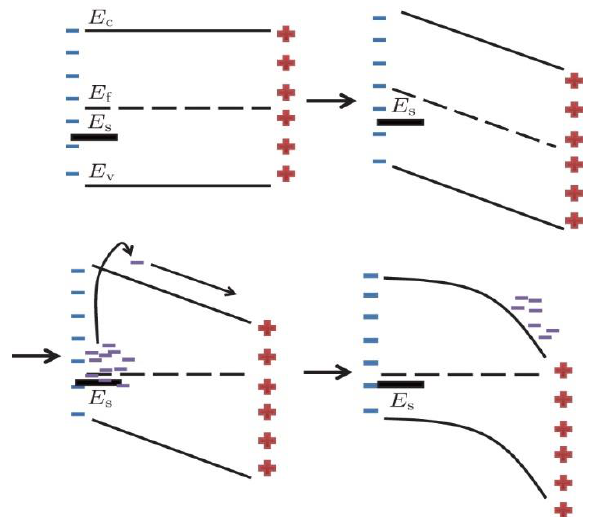
Figure 12. An undoped AlGaN material with E S surface donor states has an energy band. Electrons are advanced into the conduction band and gravitate toward the electric field created by positive polarization. Reproduced with permission from Chin. Phys. B. [31].